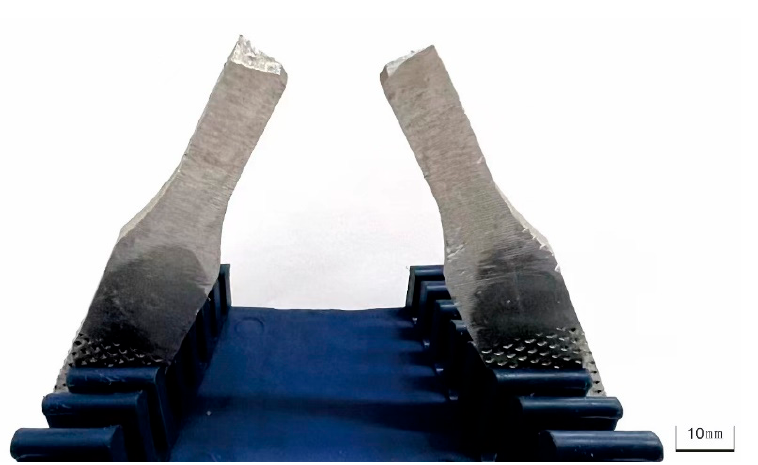
Figure 5. Fatigue fracture morphology of specimen No. 1 of dissimilar lightweight materials welded joints.